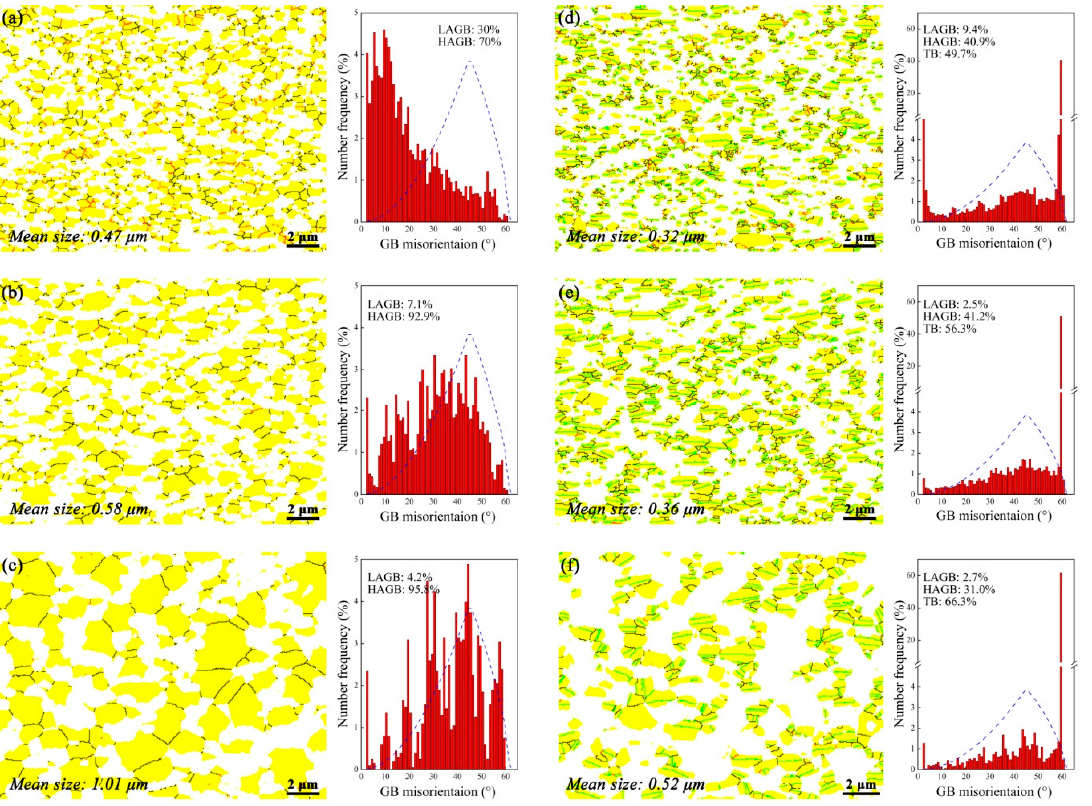
Figure 4. Grain boundary maps and the corresponding grain boundary distribution histogram for ( a – c ) β and ( d – f ) γ phase at 1050 °C under ( a , d ) 0.5 s − 1 ; ( b , e ) 0.05 s − 1 and ( c , f ) 0.005 s − 1 . The solid back and red lines denote the high angle grain boundary (HAGB) and low angle grain boundary (LAGB), respectively. The twin boundaries (TB) are in blue. The mean grain size is also tabulated on the maps. The dash blue lines represent the random distribution of grain boundary distribution. The compression axis is vertical.